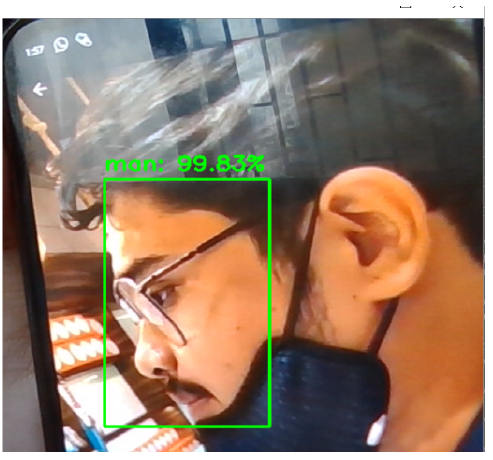
Figure 9. Male Face with side face and one-third face covered with mask